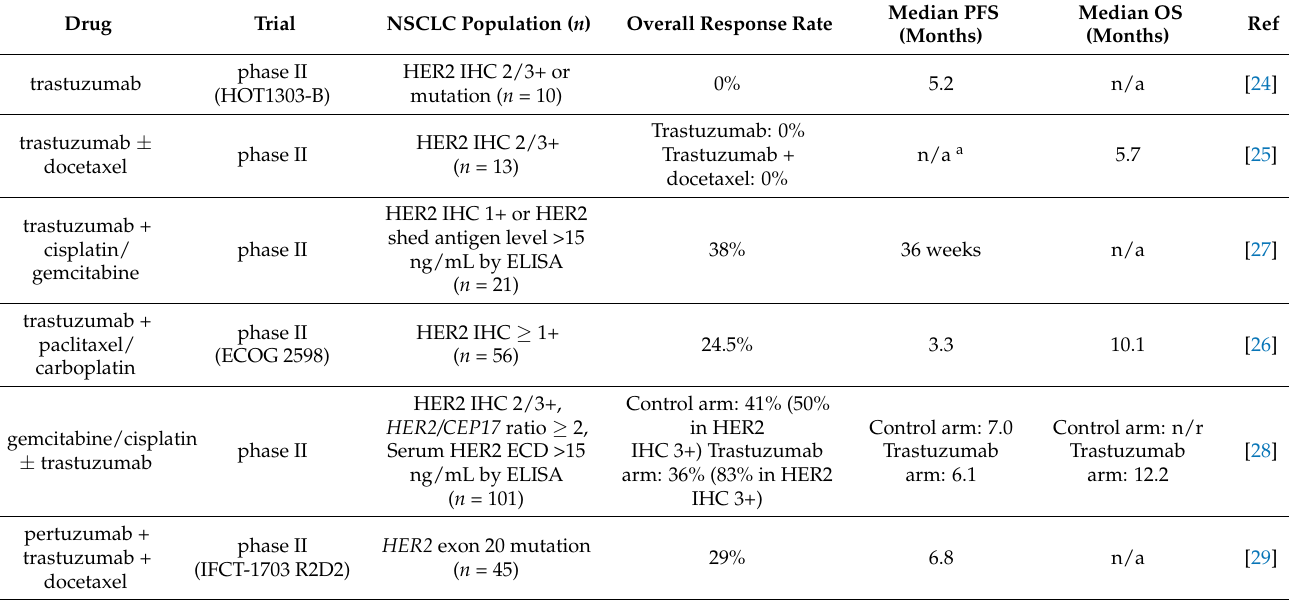
Table 2. Studies of Monoclonal Antibodies in HER2 altered